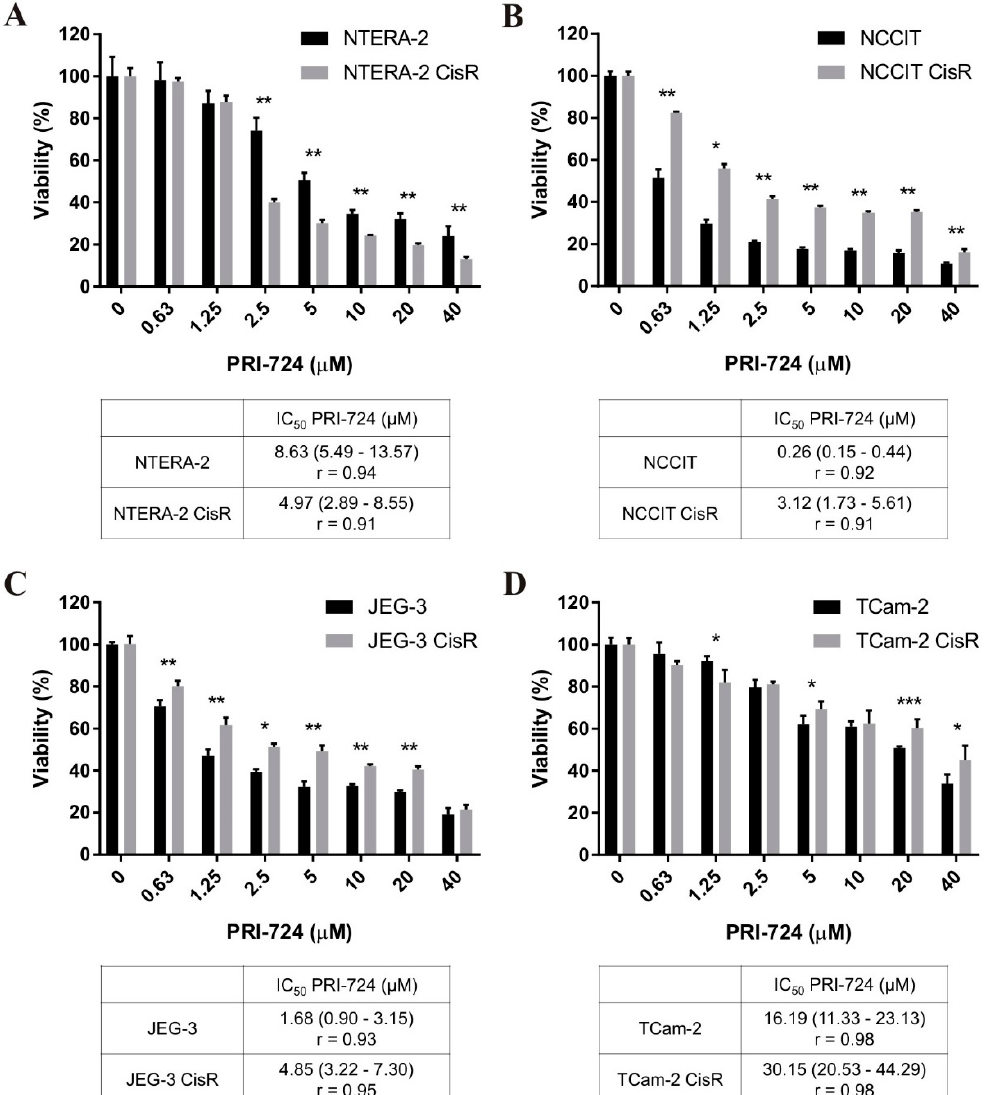
Figure 5. Only cisplatin-resistant NTERA-2 CisR cells were more sensitive to PRI-724 treatment compared to parental cells. ( A – D ) Cytotoxicity of PRI-724 in parental and resistant GCT cell lines was determined by luminescent viability assay on day 3. Values were expressed as the averages of quadruplicates ± SD and IC 50 values were stated in tables below graphs. * p < 0.05, ** p < 0.01, *** p < 0.001.